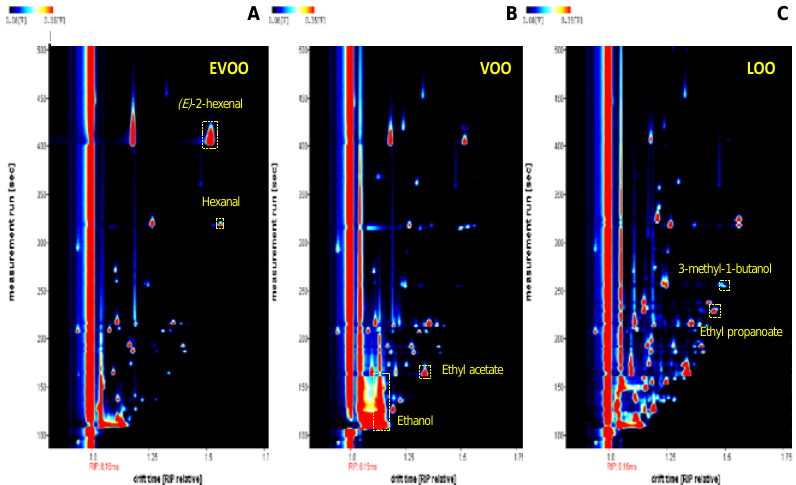
Figure 1. Heat maps in which the signals corresponding to the volatile compounds selected for the evaluation of intra- and inter-day repeatability have been indicated. ( A ) extra virgin olive oil (EVOO) sample with highlighted signals of ( E )-2-hexenal and hexanal; ( B ) virgin olive oil (VOO) sample with highlighted signals of ethyl acetate and ethanol; ( C ) lampante olive oil (LOO) sample with highlighted signals of 3-methyl-1-butanol and ethyl propanoate.